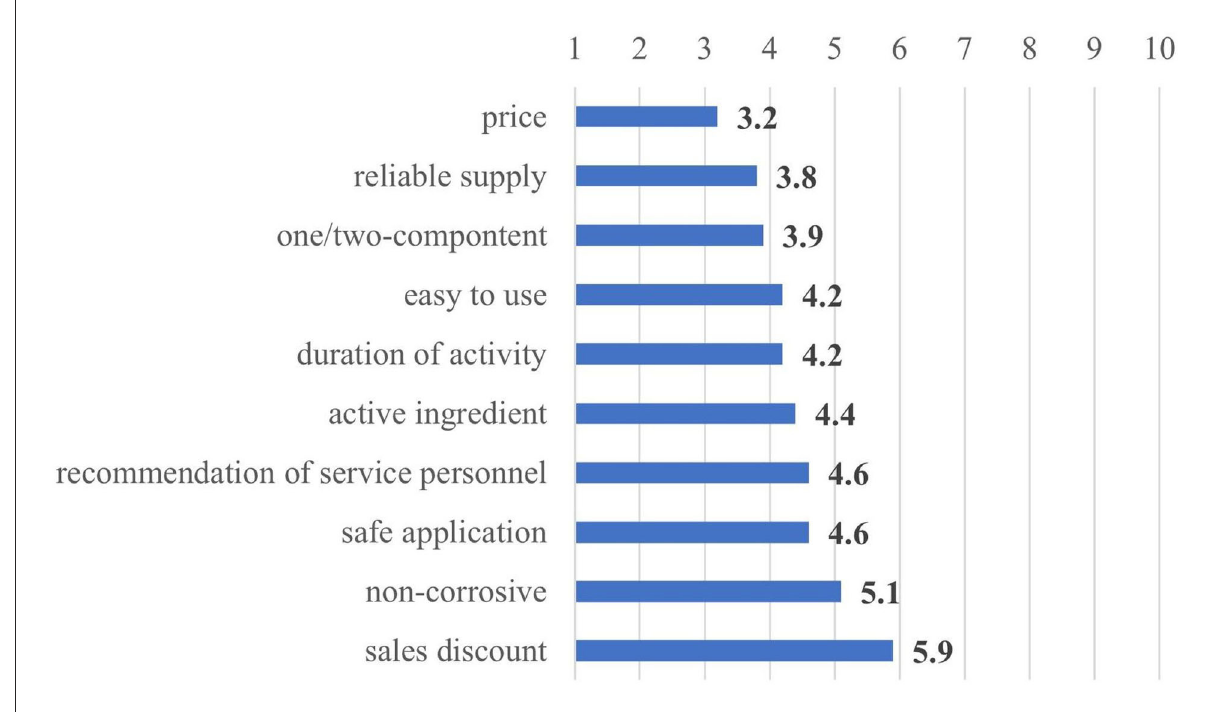
FIGURE6 Importance of different procurement factors for milking machine cleaning products ( n =